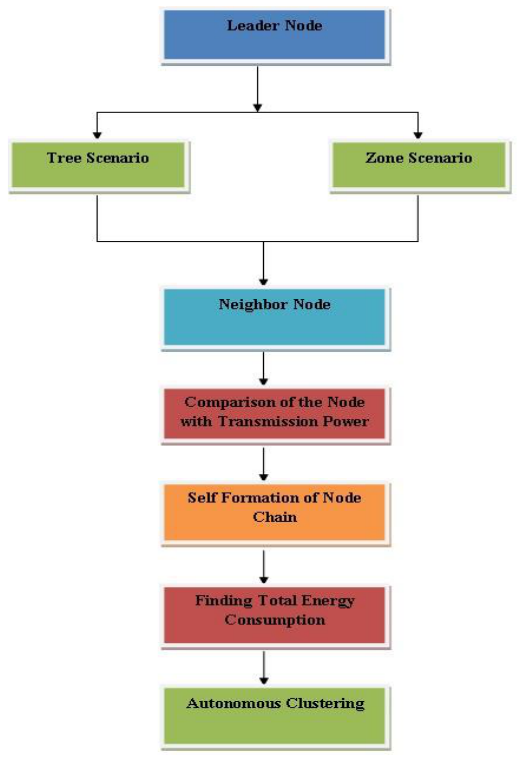
Figure 1. Flowchart of the Self-Organizing Chain.